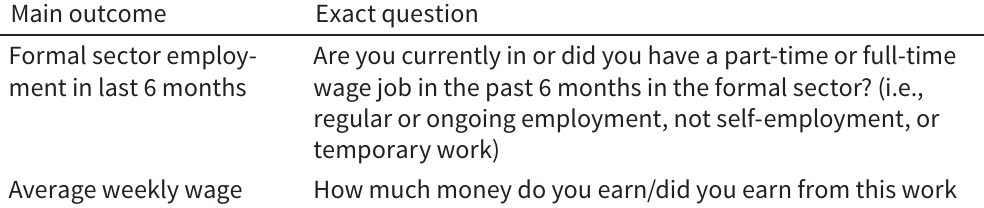
Questions that were asked to measure the main outcomes of interest Main